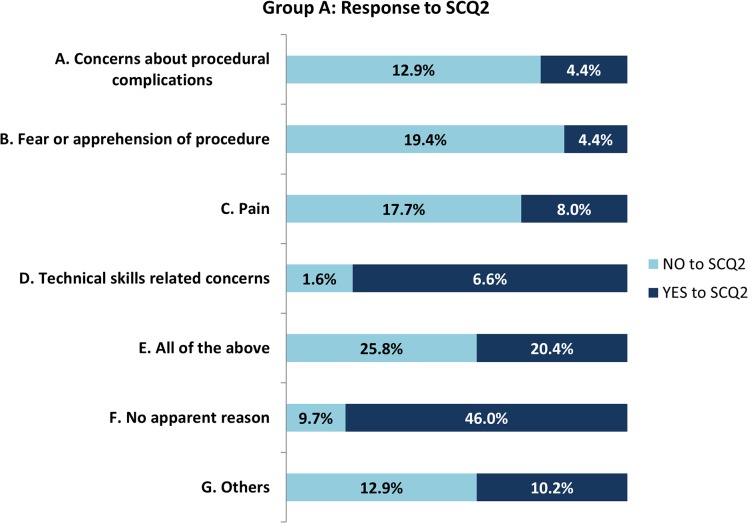
Bar chart depicting reasons for a negative response to ‘perceived ability to self-cannulate’ amongst predialysis (Group A) patients.